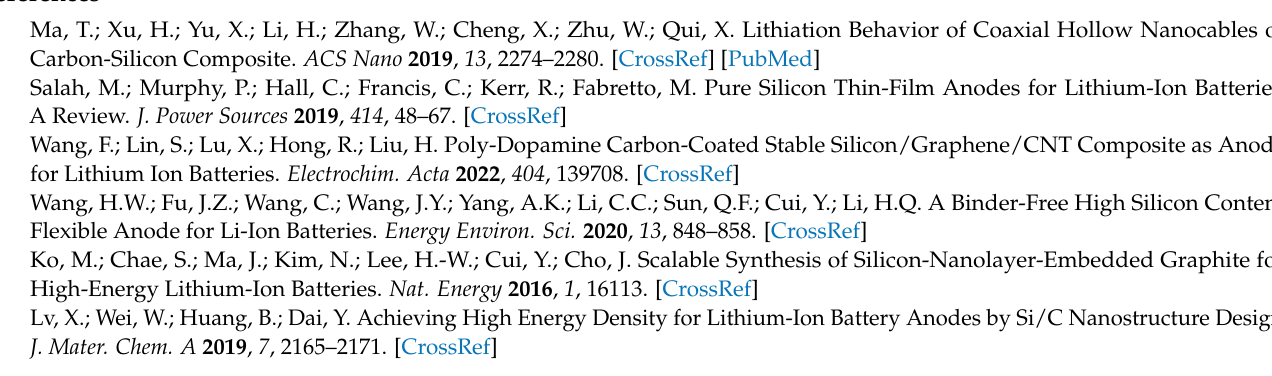
samples. Figure S4: (a) CV curves of Si, (b) CV curves of Si@C, and (c) comparison of the third cycle CV curves of the Si, Si@C, and Si/CNT@C. Figure S5: GCD curves of Si (a) and Si@C (b). Figure S6: Cycle performances of the Si/CNT/C electrode at 0.5 A g − 1. Table S1: Fitting results of the EIS curves. Table S2: Comparison among the recently reported Si-based anode materials